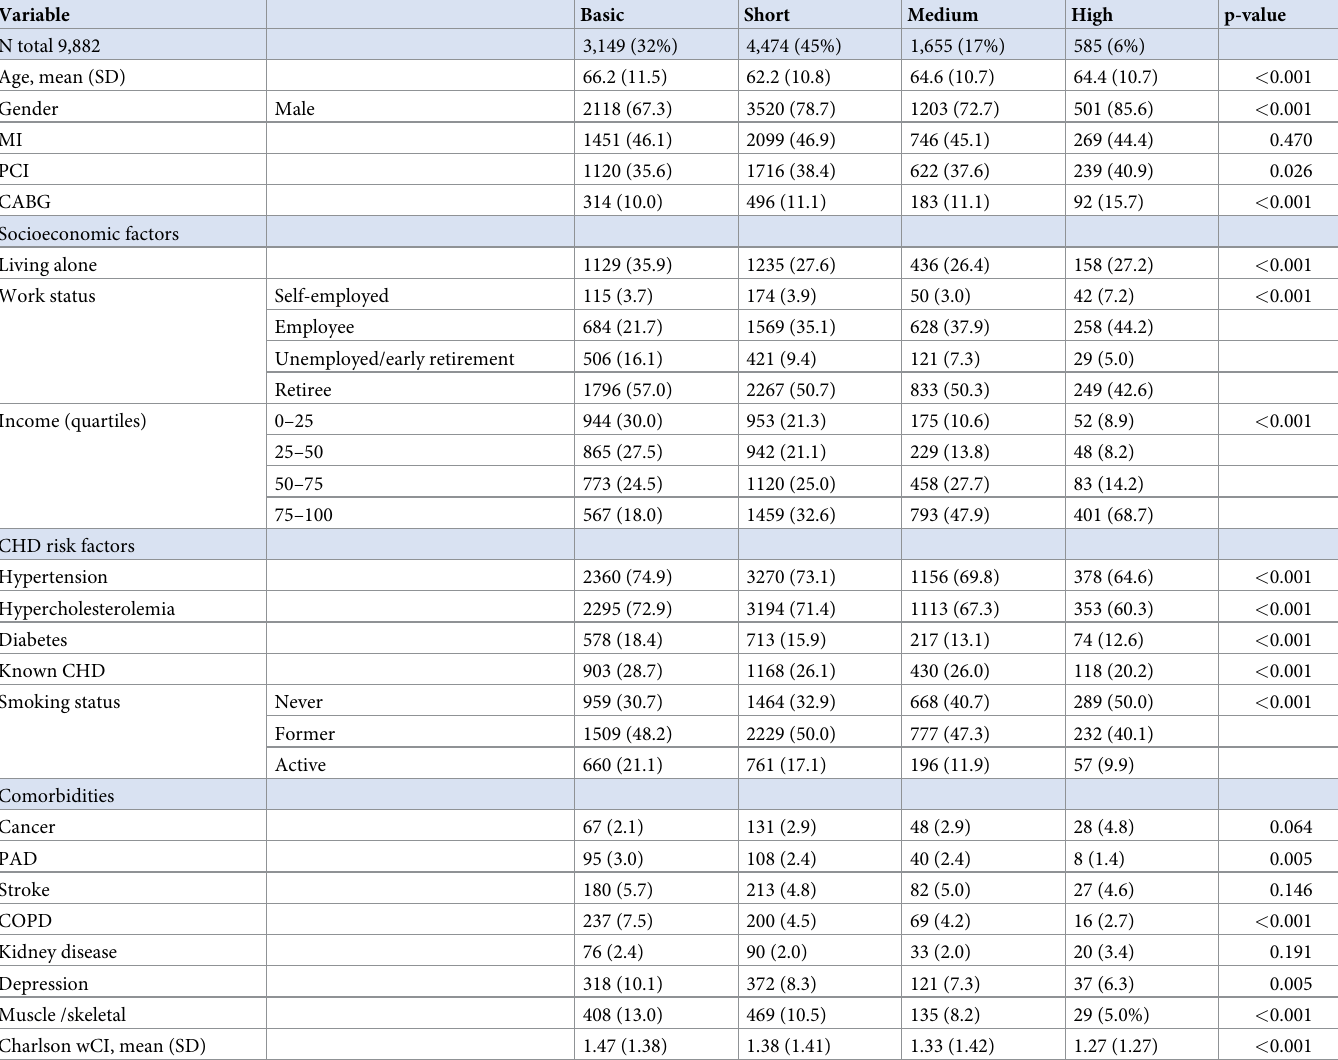
Table 1. Demographic characteristics, socioeconomic factors, and comorbidity by education among 9,882 patients in the DHRD population.